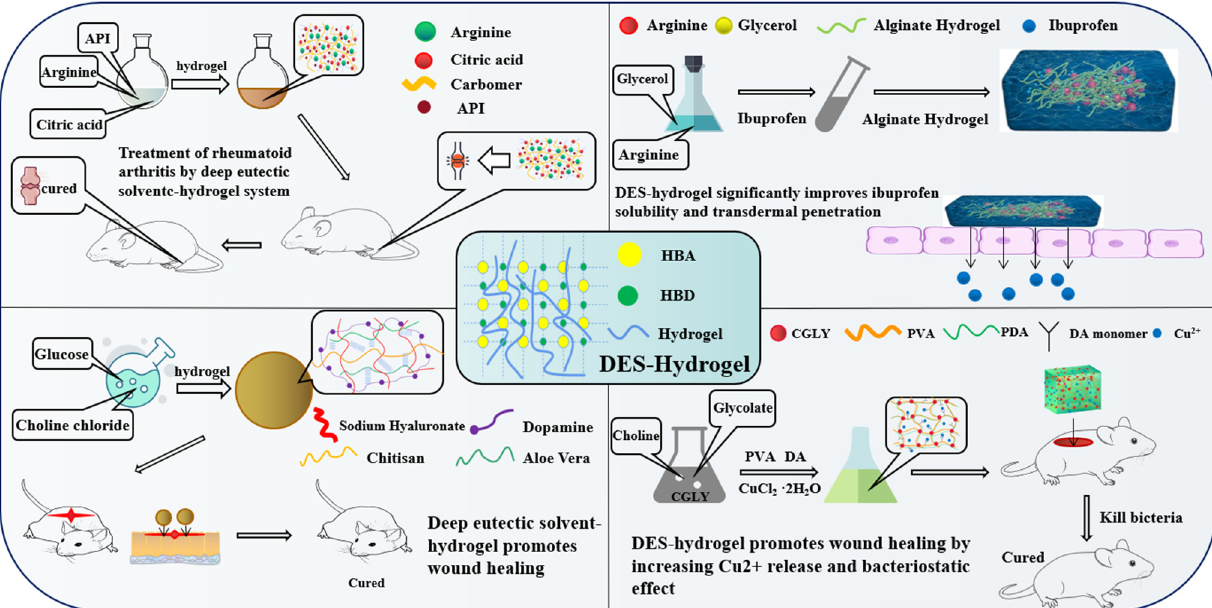
Figure 4. Applications of DES-hydrogel.